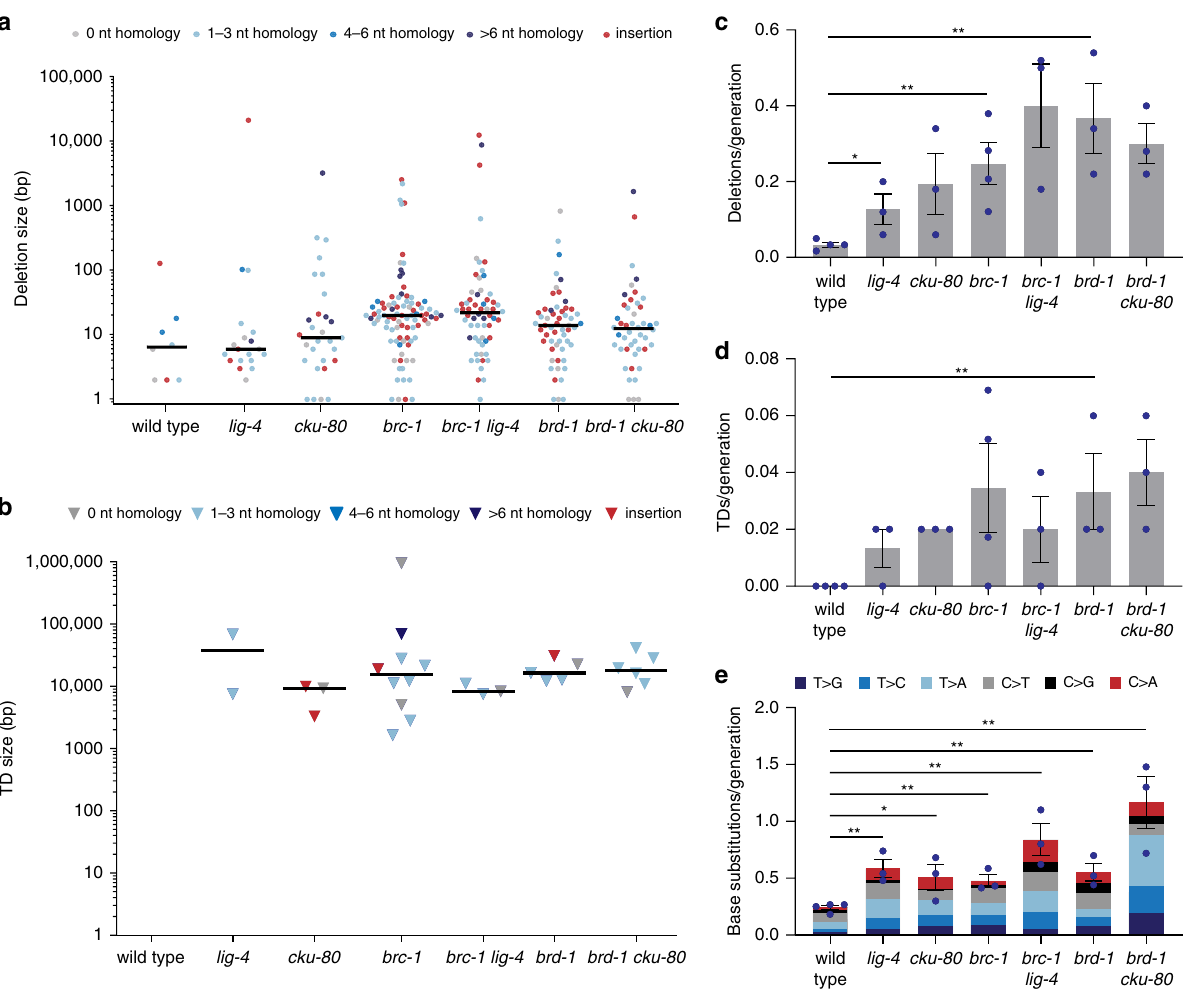
Fig. 2 NHEJ is not responsible for mutations in the genomes of brc-1 and brd-1 animals. a Size and junction representation of deletions that were obtained in wild-type and mutant animals ( n = 3 for all NHEJ-de fi cient strains). Deletions without homology are shown in grey, deletions with homology are marked in blue. Increasing homology size is depicted in increasing colour intensity. Deletions with insertions are marked in red. The median deletion sizes are indicated by horizontal lines. b Size and junction representation of TDs that were obtained in wild-type and mutant animals. TDs with homology at the junctions are marked in blue. Increasing homology size is depicted in increasing colour intensity. TDs with insertions are marked in red. The median TD sizes are indicated by horizontal lines. c Quanti fi cation of the average rate of deletions per generation in animals of different genotypes. The rate is de fi ned as the number of deletions divided by the number of propagated generations per animal. The rate per strain is represented in blue dots. Two-tailed t -tests were used to determine statistical signi fi cance (* P < 0.05, ** P < 0.01). d A quanti fi cation of the average rate of TDs per generation in animals of different genotypes. The rate is de fi ned as the number of TDs divided by the number of propagated generations per animal. The rate per strain is represented in blue dots. Two-tailed t -tests were used to determine statistical signi fi cance (* P < 0.05, ** P < 0.01). e A representation of base substitution type and the average rate of base substitutions per generation in animals of different genotypes. The different types of base substitutions are labelled with different colours. The rate is de fi ned as the number of base substitutions divided by the number of propagated generations per animal. The rate per strain is represented in blue dots. Two-tailed t -tests were used to determine statistical signi fi cance (* P < 0.05, ** P < 0.01). Error bars represent SEM. Wild type: n = 4 of 60 generations, brc-1: n = 6 of 58 generations, cku-80, lig-4, brd-1, brc-1 lig-4 and brd-1 cku-80: n = 3 of 50